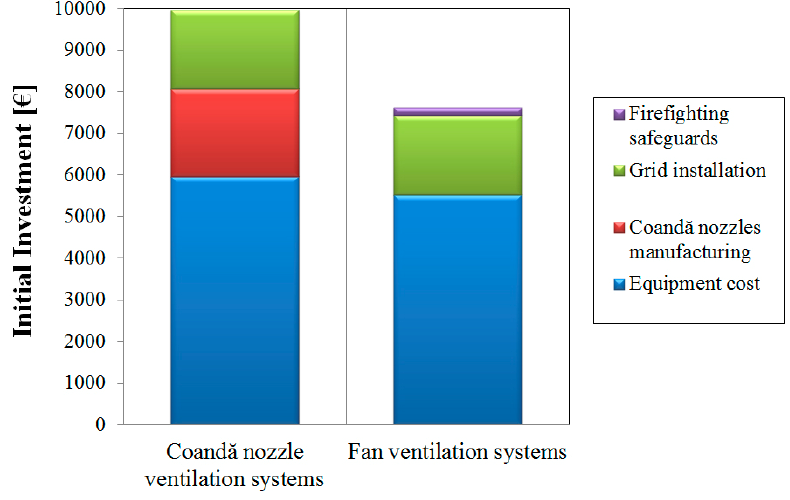
Figure 5. Comparison between investment costs of Coand ă nozzle ventilation systems and fan ventilation